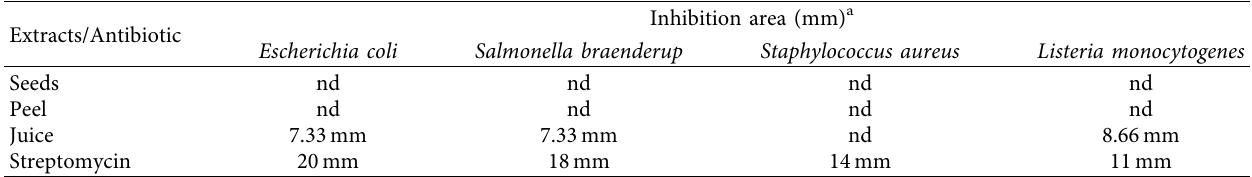
a , Mean of three repetitions; nd, not